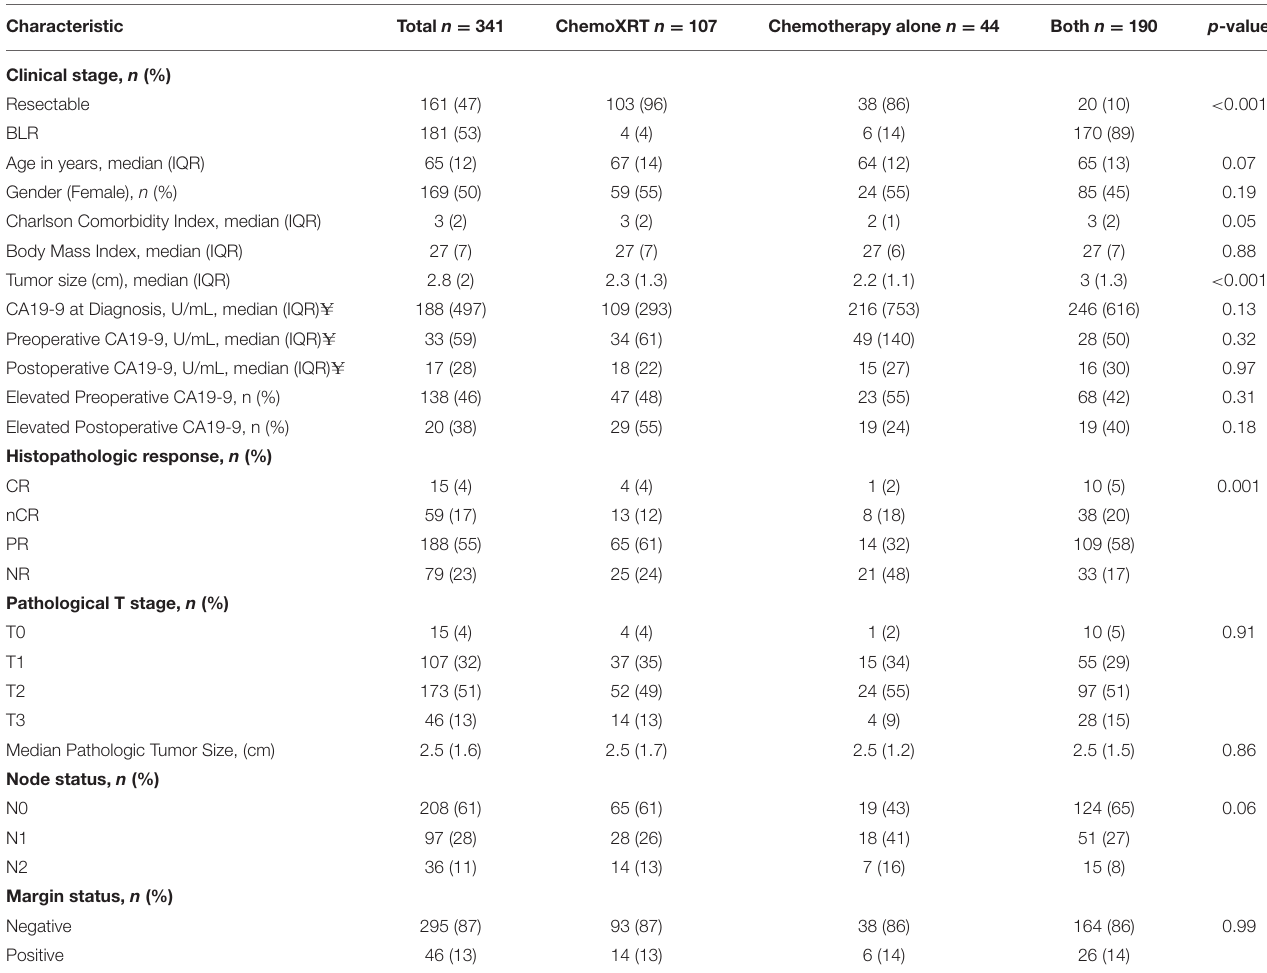
TABLE 1 | Clinical characteristics by neoadjuvant treatment modality.